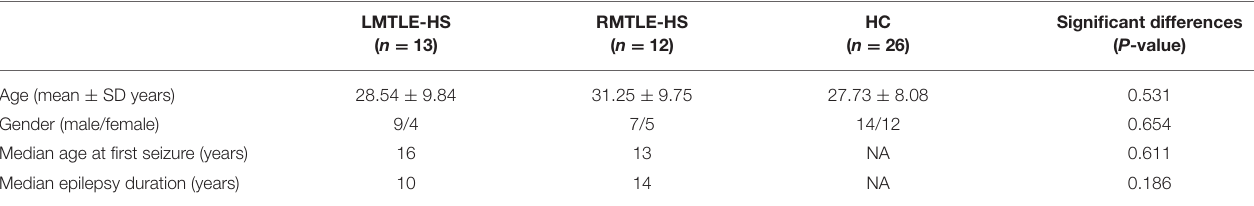
TABLE 1 | Demographic characteristics of the